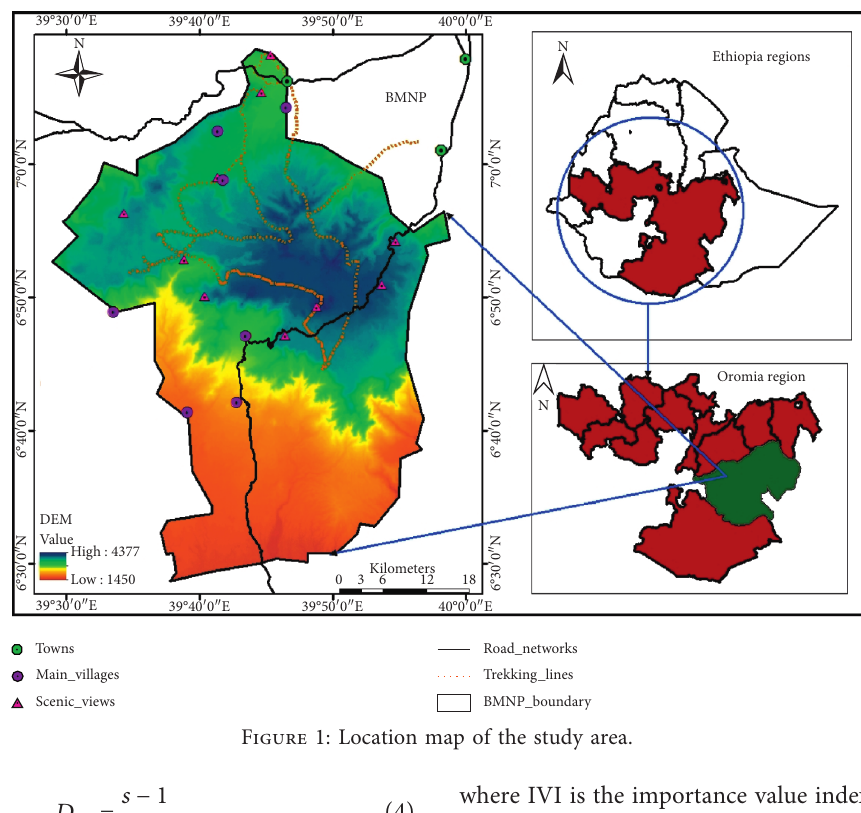
Figure 1: Location map of the study